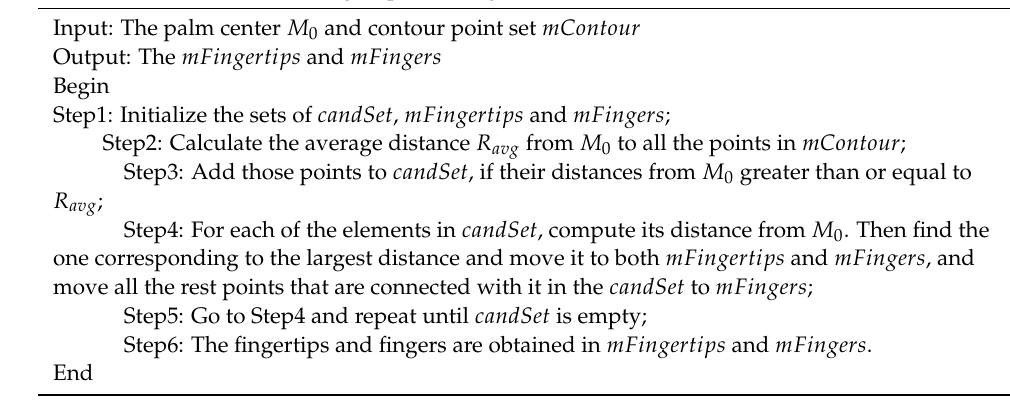
Algorithm 2 Extraction of fingertips and